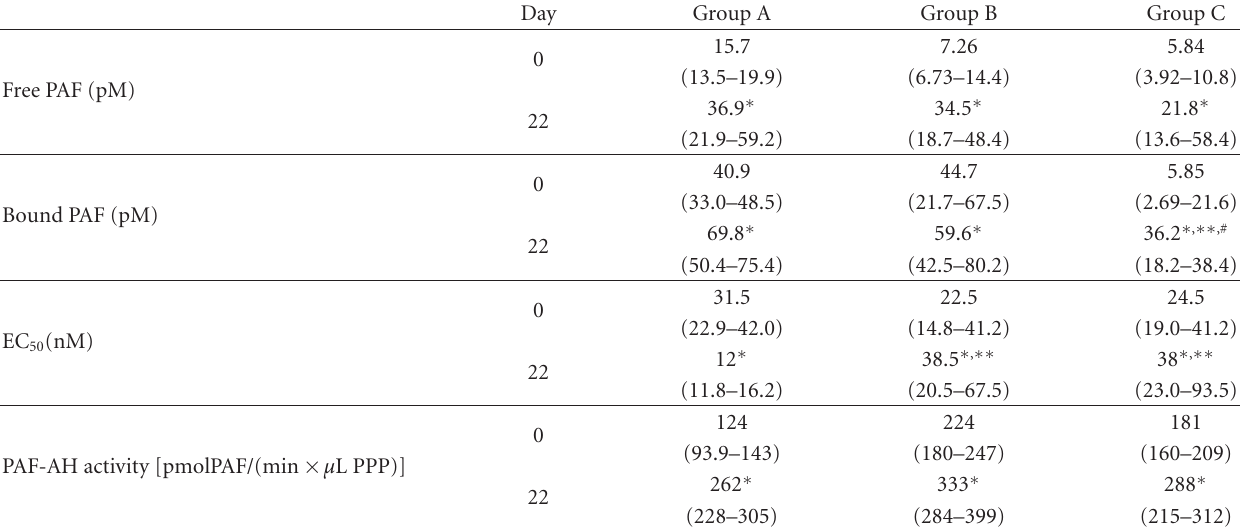
Table 4: Biochemical parameters of experimental groups.